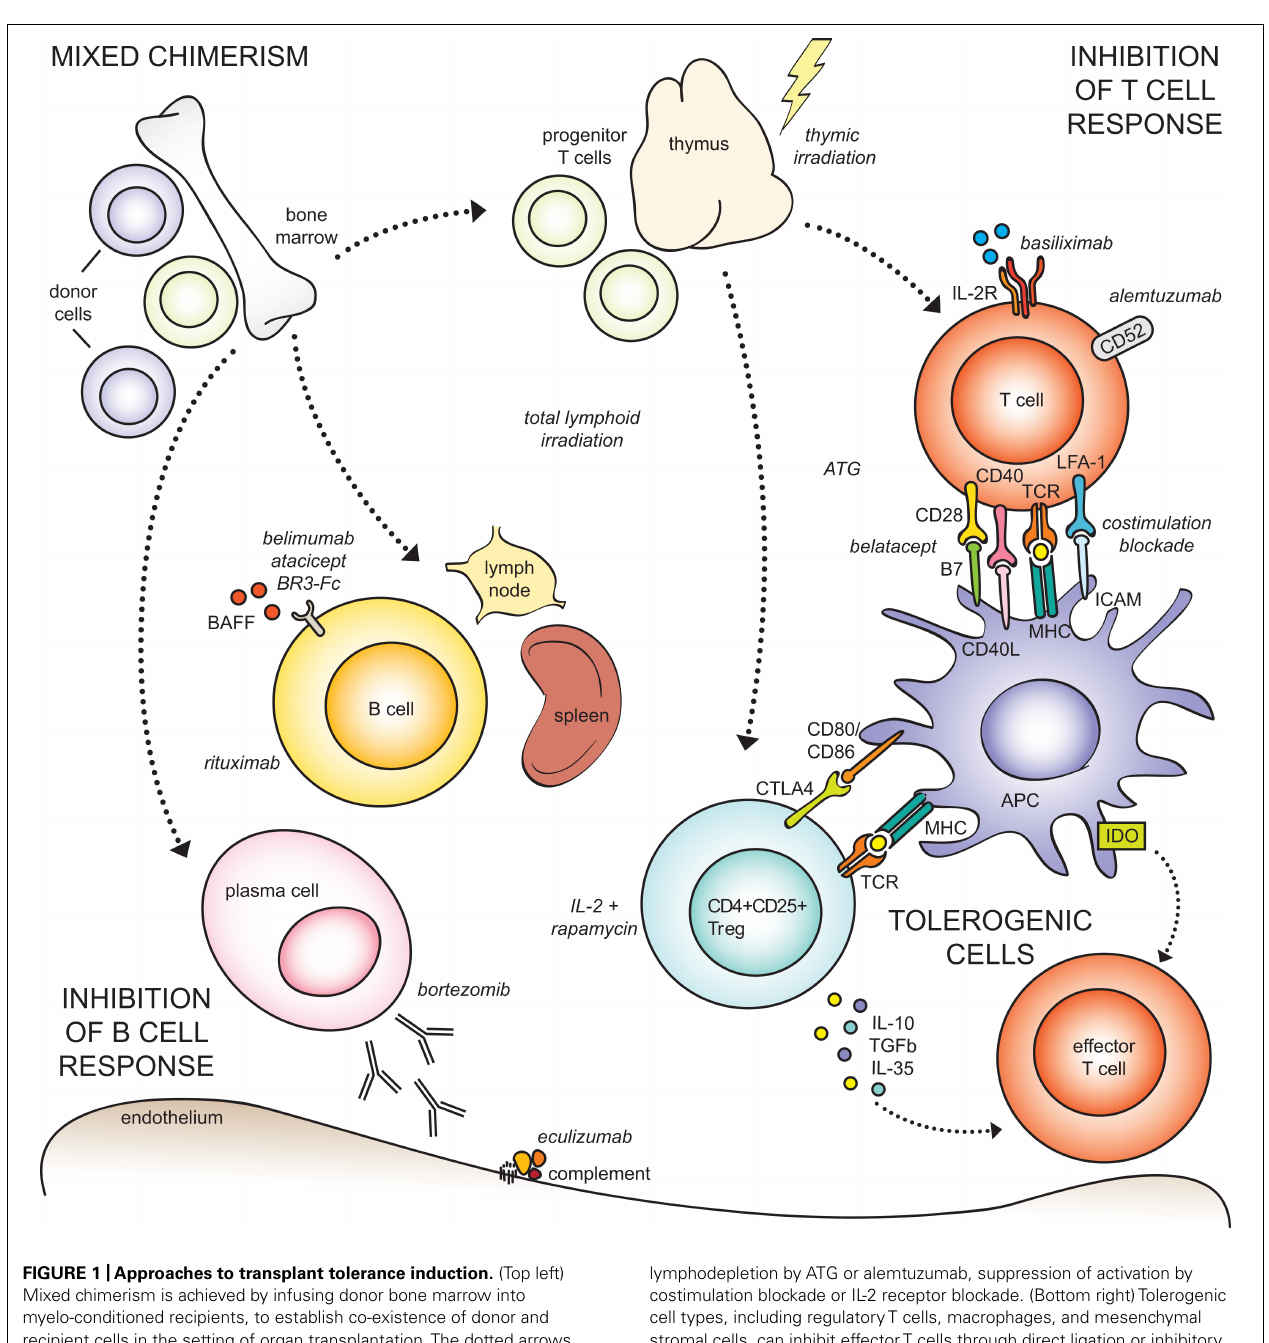
FIGURE 1 |Approaches to transplant tolerance induction. (Top left) Mixed chimerism is achieved by infusing donor bone marrow into myelo-conditioned recipients, to establish co-existence of donor and recipient cells in the setting of organ transplantation.The dotted arrows indicate cell types originating from the bone marrow, unrelated to mixed chimerism. (Top right) AllospecificT cell responses can be abrogated through a number of mechanisms, including irradiation, pharmacologic